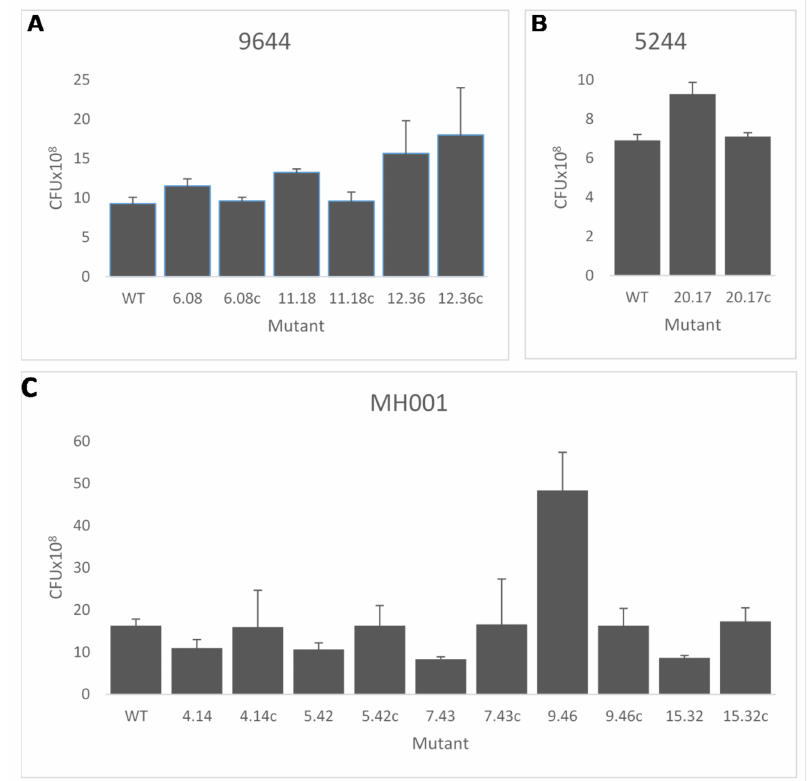
Figure 5. Growth of selected Pseudomonas syringae transposon disruption mutants and complemented strains in woody tissue. ( A ) Pss 9644 (6.08, pyridoxine/pyridoxamine 5 (cid:48) -phosphate oxidase; 11.18, nhaA ; 12.36, arginine-ornithine antiporter). ( B ) Psm R1 5244 (20.17, argE ). ( C ) Psm R2 MH001 (4.14, phosphoglycerate mutase, 2,3-bisphosphoglycerate; 5.42, DNA ligase D; 7.43, hrcS ; 9.46, hopAU1 ; 15.32, fliK ). Growth in cherry cv. Van shoots was assessed at 14 days. c, complemented strain. Error bars represent the standard error of the mean of three WT biological replicates. Figure shows only mutants that had significantly different growth compared to the WT strain determined as p < 0.05 by Student’s t